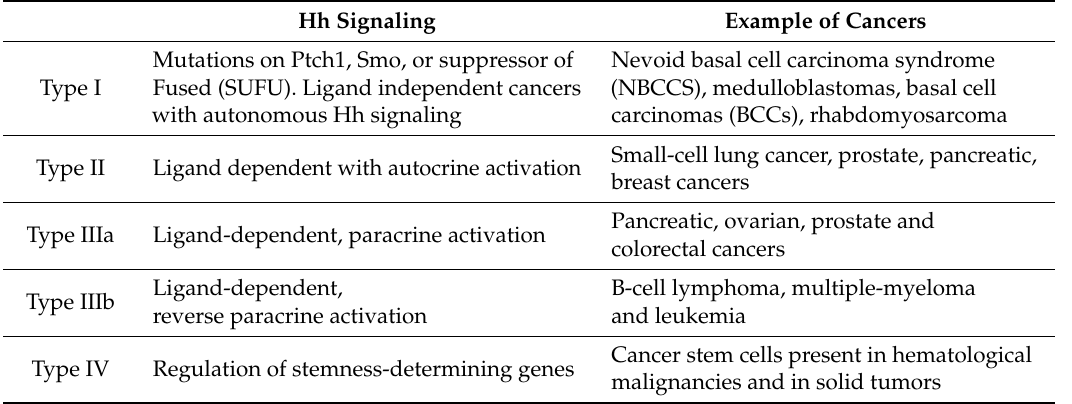
Table 2. Modes of signaling in Hedgehog (Hh) pathway-dependent